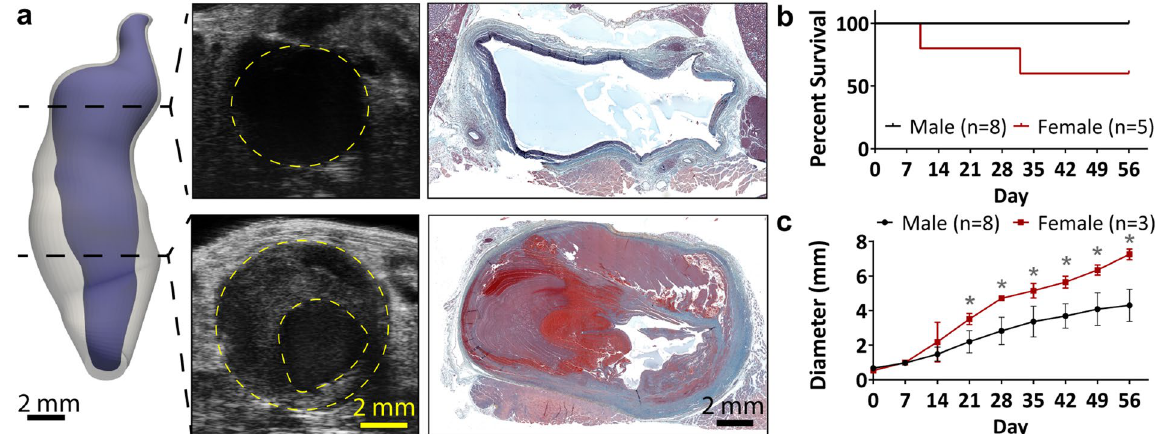
Figure 6. Female elastase-treated mice. Combined treatment of elastase and BAPN in female mice resulted in large aneurysms. ( a ) Similar to the male mice, these aneurysms tended to have a thin, proximal region and a thick, thrombus-laden distal region. ( b ) In addition, two of the five female mice died before end-of-study. ( c ) Among the remaining female mice, maximum diameter was significantly larger than that of the males, beginning on Day 21. * p < 0.05 for male and female comparison within each time